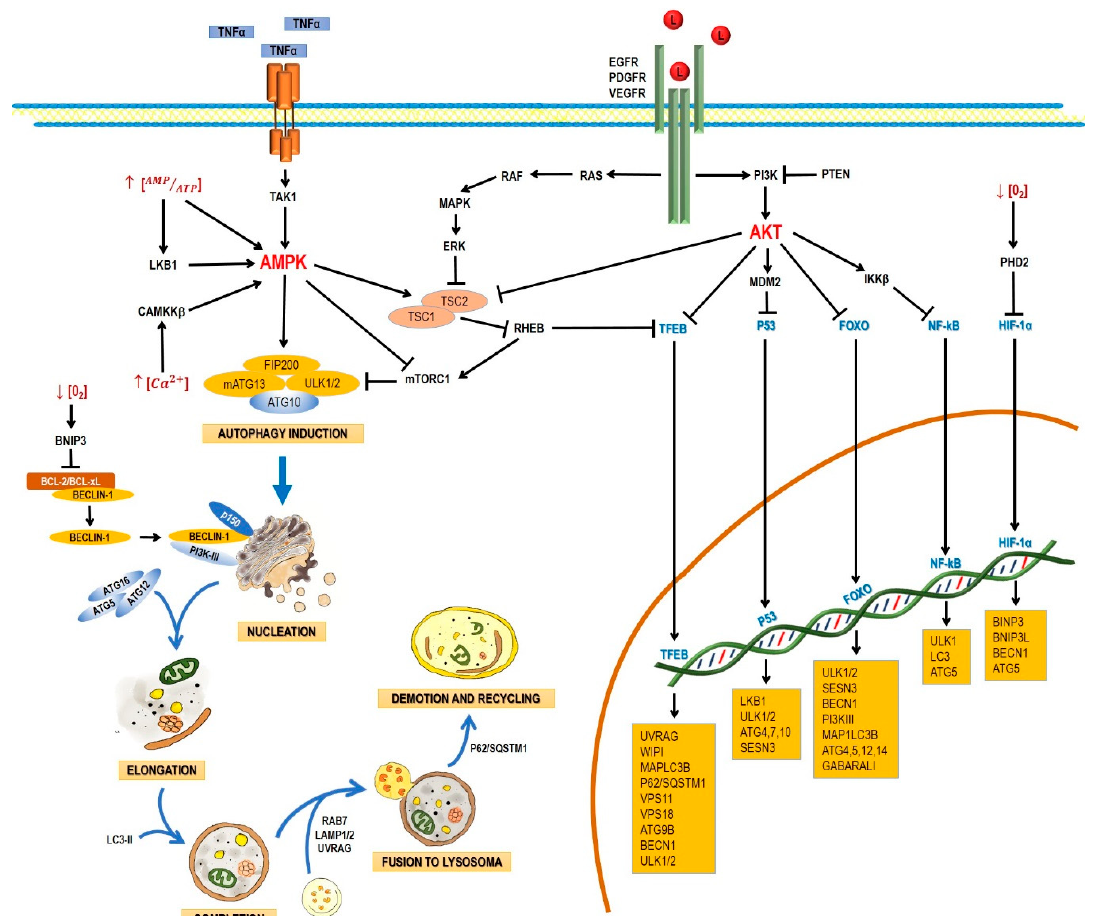
Figure 1. Schematic process of the autophagic pathway. Autophagy consists of the following stages: induction, phagophore nucleation, elongation, and completion; fusion to lysosome, degradation, and recycling. Receptor tyrosine kinases (EGF (epidermal growth factor receptor), PDGF (platelet-derived growth factor receptor), and VEGF (vascular endothelial growth factor receptor)) stimulate the RAS/RAS/ERK and PI3K/AKT signaling pathways, which traduce signals to activate transcription factors, such as transcription factor EB (TFEB), FOXO, P53, and NF- к B, which regulate the expression of genes that are key for autophagy induction. Then, the activation of AKT inhibits autophagic death by activating the mTORC1 complex, which contains mTOR. During nutrient deprivation, AMPK stimulates autophagy by phosphorylation of ULK1 and suppression of mTORC1, which inhibits autophagy by inactivating ULK1. Autophagy can also be induced by hypoxic conditions through HIF activation. Autophagosome biogenesis starts with the formation of an initiation membrane, derived from the endoplasmic reticulum (ER) or other cellular membrane sources. Vesicle nucleation requires the activity of the PI3K-III/Beclin-1 complex. The completion and expansion of the autophagosome requires the Atg5/Atg12/Atg16 and LC3-PE proteins. Mature autophagosome fuses with a lysosome to form the autophagosome, which requires the action of proteins, such as Rab7, UVRAG, and Lamp 1, 2; finally, p62/SQSTM1 is required for the degradation and recycling of the cellular components. Black arrows ( ↓ ) indicate activation, and black truncated arrows ( ⊥ ) indicate inhibition. Blue arrows ( ↓ ) indicate the process of the autophagic